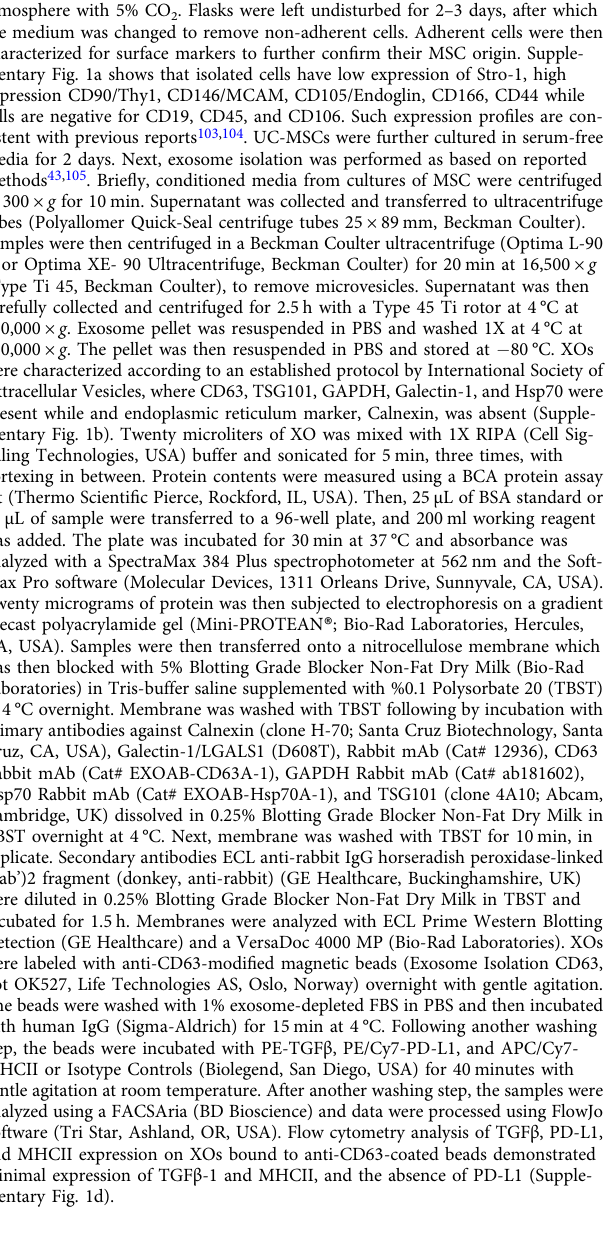
Fig. 5 XOs suppress human peripheral blood mononuclear cells and macrophages. a Human peripheral blood mononuclear cells (PBMCs) were